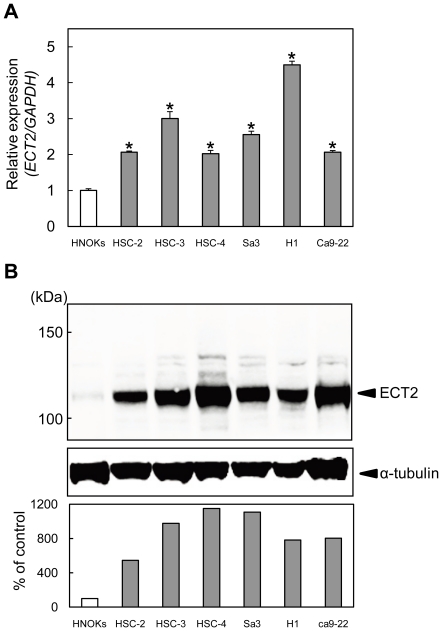
ECT2 exprssion in OSCC-derived cell lines.(A) Quantification of ECT2 mRNA levels in OSCC-derived cell lines by qRT-PCR analysis. To determine mRNA expression of ECT2 in Oral cancer, we performed qRT-PCR analysis using six OSCC-derived cell lines (HSC-2, HSC-3, HSC-4, H1, Ca9-22, and Sa3) and HNOKs. Significant up-regulation of ECT2 mRNA is seen in six OSCC-derived cell lines compared with that in the HNOKs. Data are expressed as the means ± SEM of values from three assays (*p<0.05; Mann-Whitney U test). (B) Western blot analysis of ECT2 protein in the OSCC-derived cell lines and HNOKs. To investigate protein expression of ECT2 in Oral cancer, we performed Western blot analysis using six OSCC-derived cell lines (HSC-2, HSC-3, HSC-4, H1, Ca9-22, and Sa3) and HNOKs. ECT2 protein expression is up-regulated in OSCC-derived cell lines compared with HNOKs. Densitometric ECT2 protein data are normalized to α-tubulin protein levels. The values are expressed as a percentage of the HNOKs.